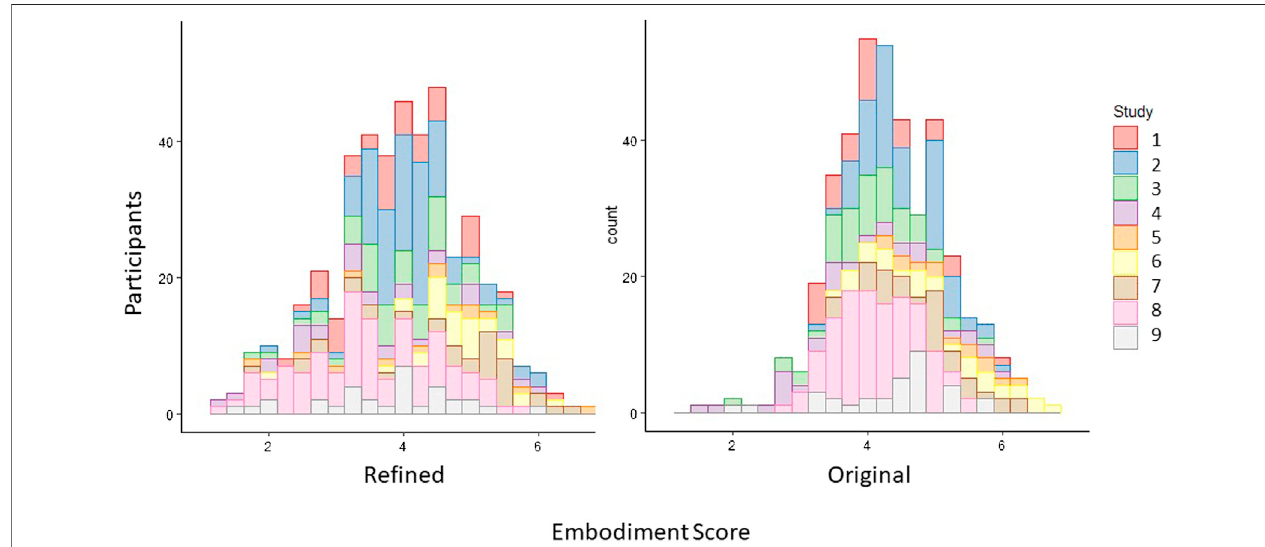
FIGURE 1 | The distribution of scores for the new re fi ned scale and original scale for each of the nine studies.